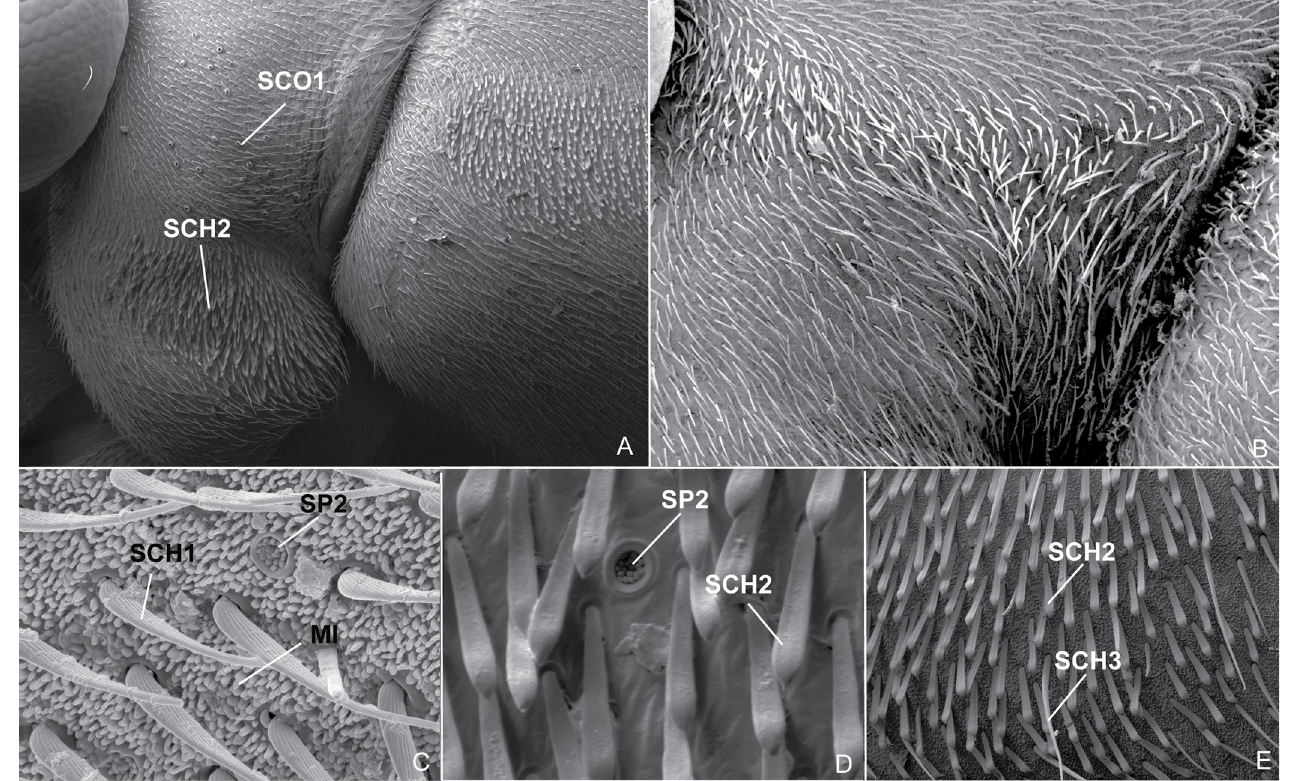
Fig 17. Scanning electron micrographs. (A) P . horvathi , propleurum, vista lateral; (B) B . thomasi comb. Nov. , propleuron, lateral view; (C) P . unidentatus , head, dorsal view; (D) P . horvathi , mesopleuron, lateral view; (E) P . shuar , propleuron, lateral view. MI: Microtrichia; SCH1: Sensilla chaetica 1; SCH2: Sensilla chaetica 2; SCH3 : Sensilla chaetica 3; SCO1: Sensilla coeloconica 1; SP2 Sensilla placodea 2.